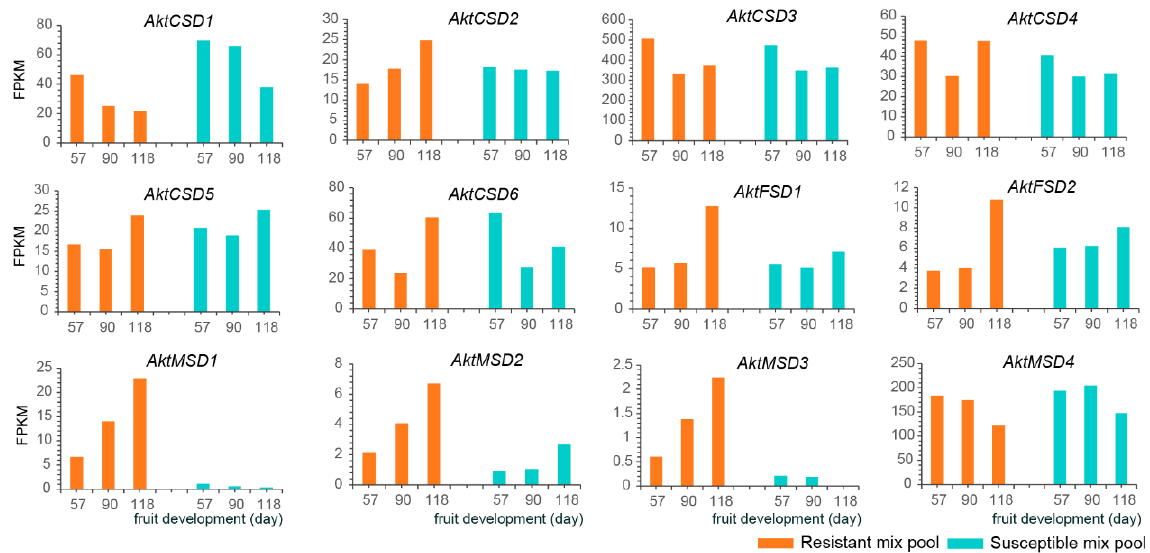
Figure 7. Expression-level analysis of 13 AktSODs in resistant and susceptible rinds.